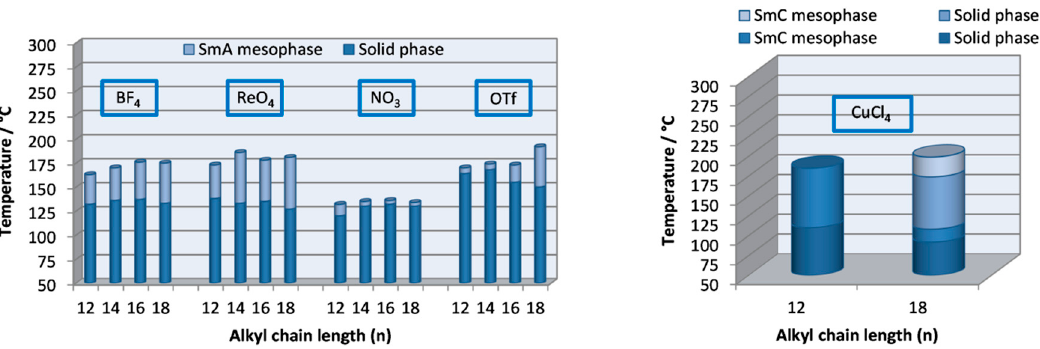
Figure 3. Phase transition temperatures of the different salts as dependent on the anion and the cation length.